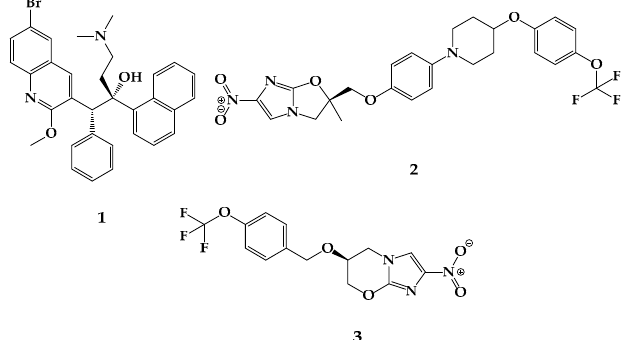
Figure 1. Anti-tubercular drugs 1, 2 and 3, which are approved in last 10 years [22].